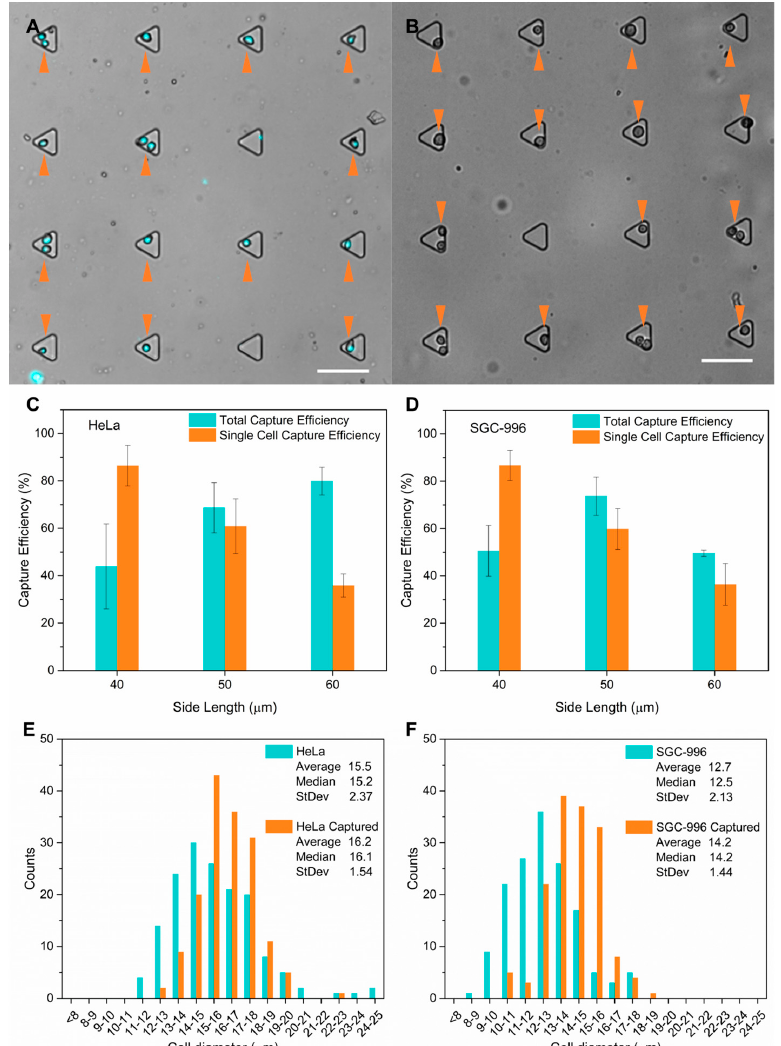
Figure 7. Cell capture performance. HeLa and human gallbladder carcinoma cells (SGC-996) suspension at a concentration of 4 × 10 6 cells/mL was used, respectively. ( A ) HeLa cells stained with Hoechst 33258 (cyan colored) were captured in the microwells after washing. Scale bar is 100 μ m; ( B ) HeLa cells were released from the microwells and fell on the protein patterns (non-fluorescently labeled). Note that there was a distance of 50 μ m from the microwells to the paired patterns, and the focus plane was on the microwells; the blurred cells indicated that they had fallen out of the microwells. Scale bar is 100 μ m; ( C , D ) cell capture efficiencies of triangle microwells with three side lengths. The total capture efficiency for HeLa cells increased with the side length while a peak efficiency was achieved with 50 μ m side length microwells for SGC-996 cells. The single capture efficiency for both types of cells dropped dramatically when the side length increased from 40 to 60 μ m; ( E , F ) size distributions of the original cells and captured single cells by 50 μ m side length microwells of HeLa and SGC-996 cells. Diameters of captured HeLa single cells concentrated in a range of 15–18 μ m and 13–16 μ m for captured SGC-996 cells, while the origin cells distributed in wider ranges. The average diameter of the captured single cells of both types increased while the standard deviations dropped, implying a promoted uniformity of cell size.